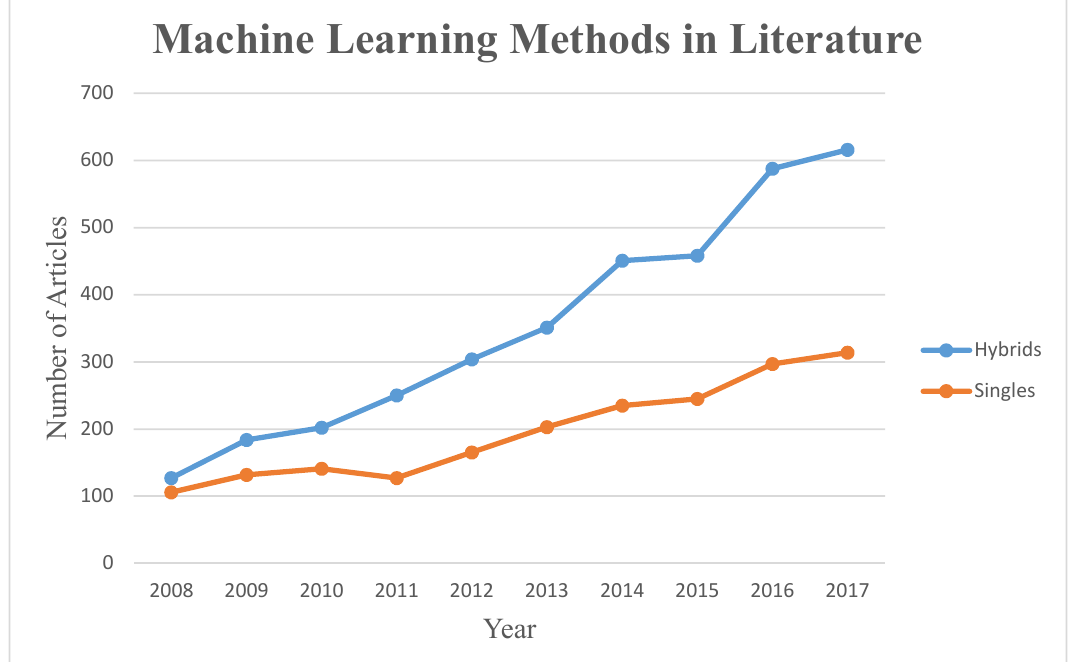
Figure 4. The progress of single vs. hybrid ML methods for flood prediction in the literature. Reference year: 2008 (source: Scopus).